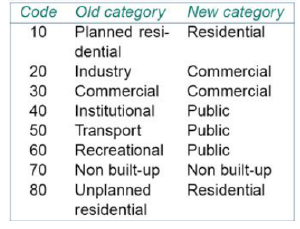
Figure 2. User controlled classification method